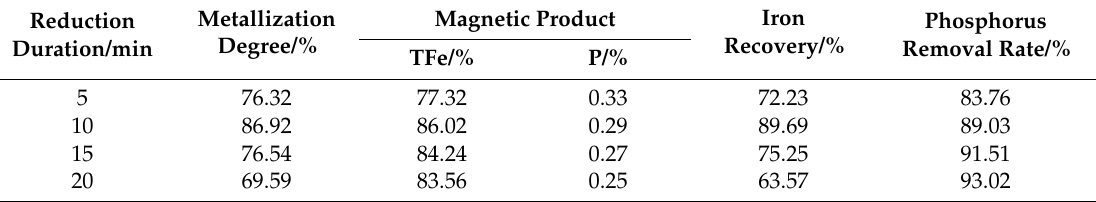
Table 5. Effects of reduction duration on phosphorus removal and magnetic separation.